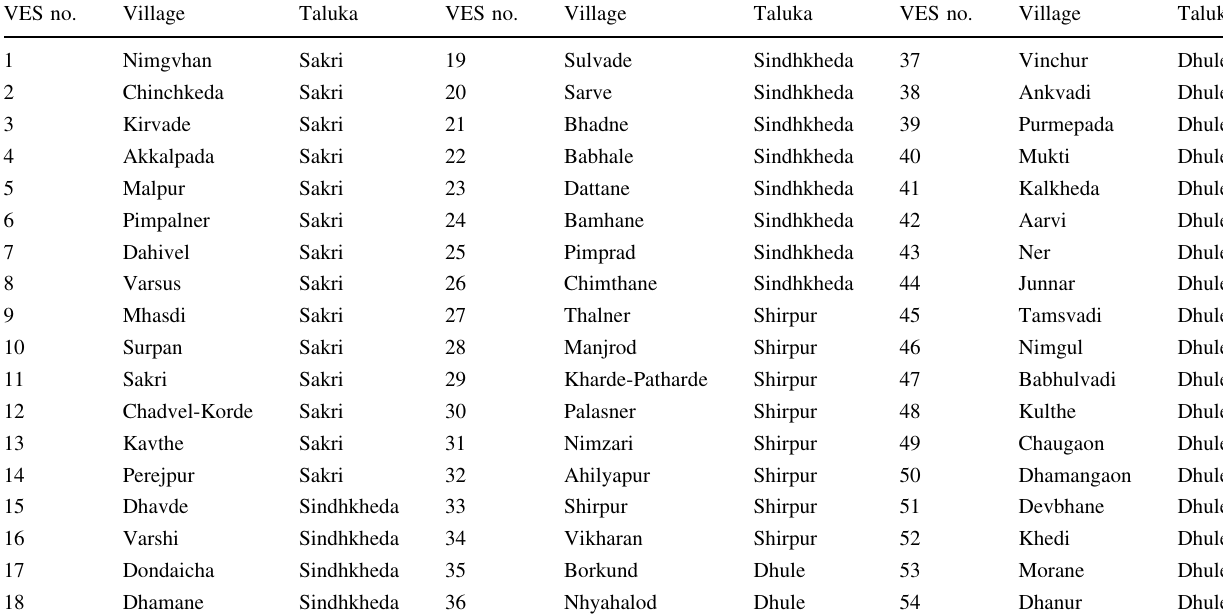
Fig. 3 VES location map along with geo-electric section and resistivity geo-electric section along NE–SW and NW–SE from Dhule district